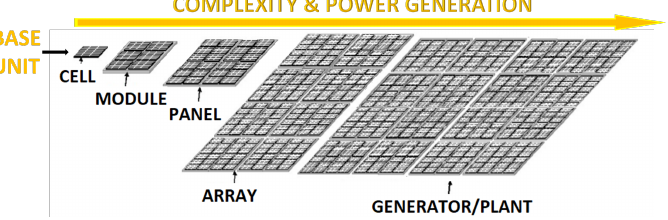
Figure 13. Distinction about different photovoltaic architectures: from a cell to generators and parks (adapted from